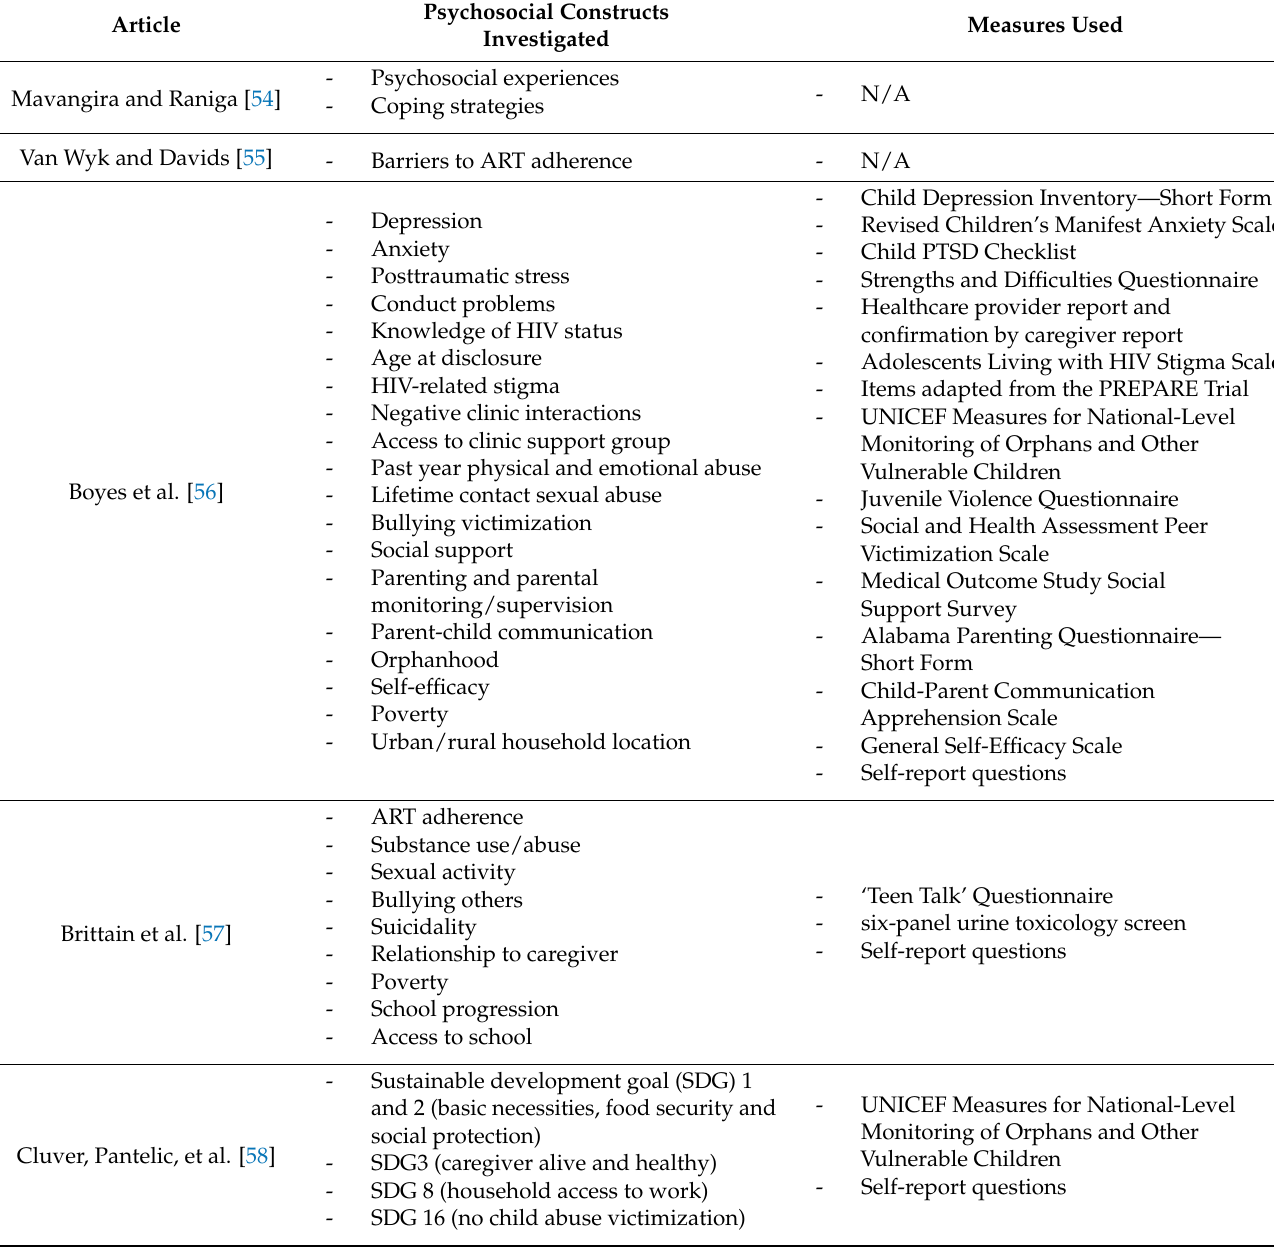
Table 3. Psychosocial Constructs and Quantitative Measures Under